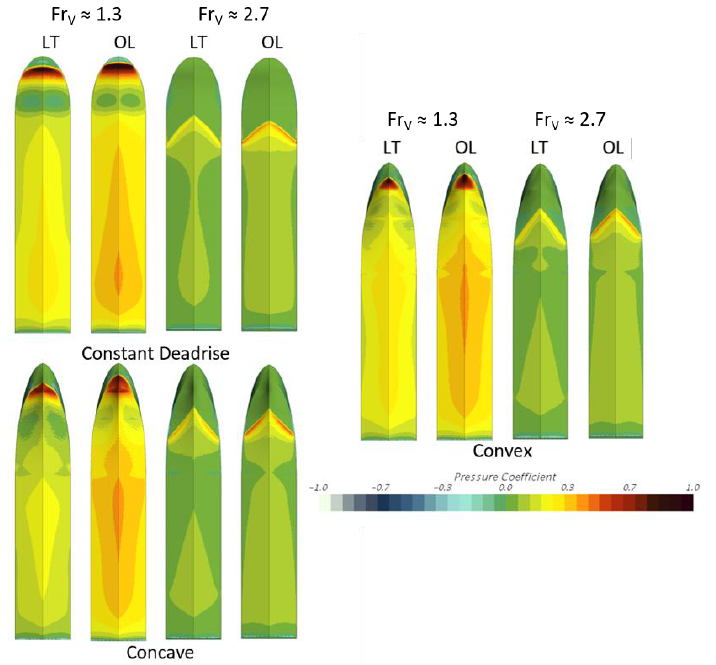
Figure 15. Comparison of pressure coefficient for each hull form at LCG = 45% and Froude numbers 1.3 and 2.7 for both lighter (LT) and overloaded (OL) configurations.